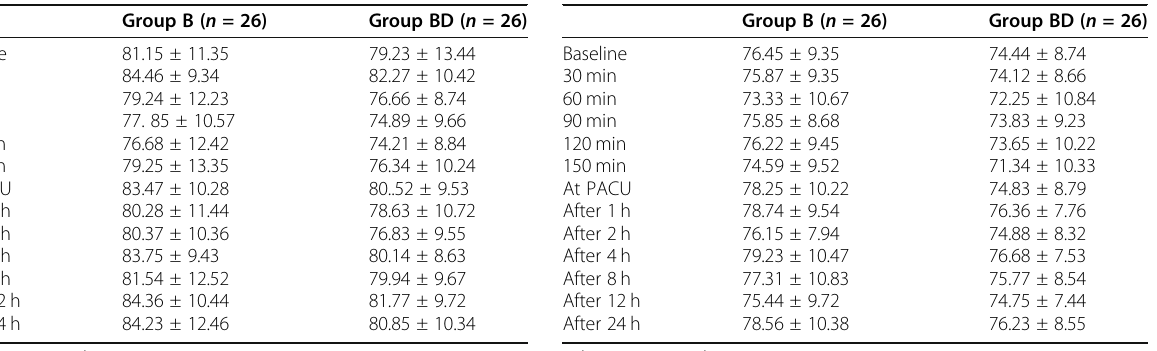
Table 2 Dermatomal distribution of sensory blockade of SAP block Dermatomal distribution of the SAP block